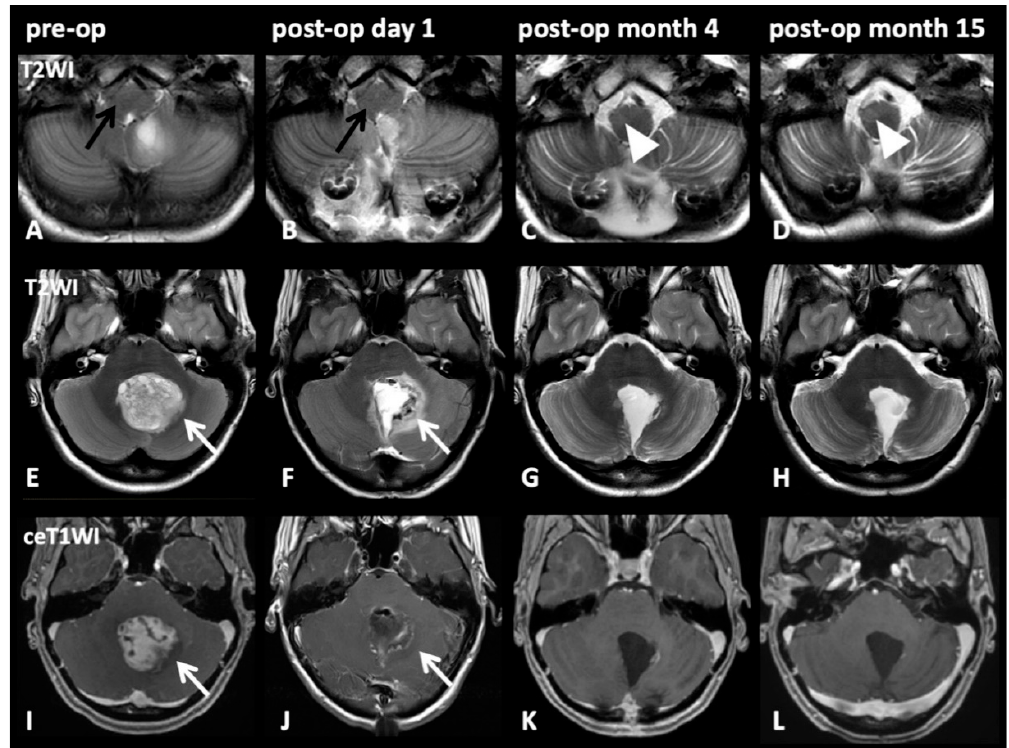
Figure 4. Image series on patient number five from Table 2: Pre-op (1st column), post-op day 1 (2nd column), post-op month 3 (3rd column), post-op month 14 (4th column). T2WI axial slices on medullary level ( A – D ) and on pontine level ( E – H ) with corresponding pontine axial contrast enhanced T1WI ( I – L ). A 17-year-old female patient presented with cerebellar pilocytic astrocytoma affecting the left dentate nucleus ( E , I ; white arrows). Initially ( A ; black arrow) and after complete resection via a paravermal approach 6 days later ( F , J ; white arrows), no HOD is visible ( B ; black arrow). However, after 3 months ( C , white arrow) and still after 14 months ( D ; cropped image, arrowheads), HOD with hyperintensity on T2WI on the right side can be found. No signs of tumor recurrence but only discrete scarring is visible after 3 and 14 months ( K , L ).